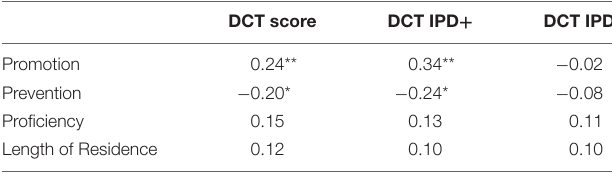
TABLE 4 | Pearson correlations between predictors and pragmatic production measures.